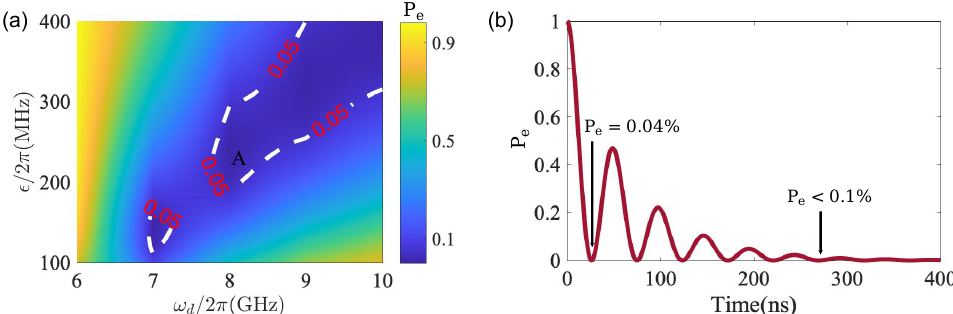
Figure 3. ( a ) Two-dimensional scan of the | 0 e 0 (cid:105) population by adjusting the amplitude ( (cid:101) ) and the frequency ( ω d ) of the mixing pulse. ( b ) Time evolution of the qubit excited state population, after para- metric optimization corresponding to the point A, with (cid:101) = 2 π × 240 MHz and ω d = 2 π × 8.2 GHz. At 28 ns, the population of the | 0 e 0 (cid:105) decays to the first minimum value 0.04% and remains below 0.1% after 283